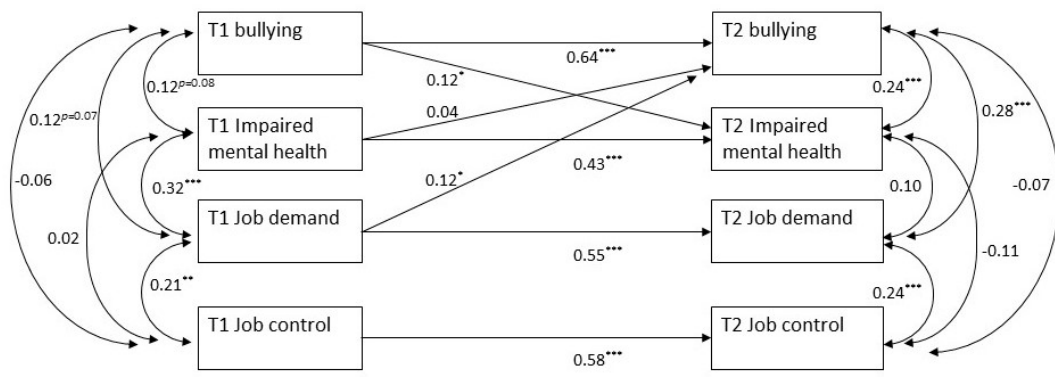
Figure 1. Path analytic model testing the impact of T1 job demand and T1 impaired mental health on T2